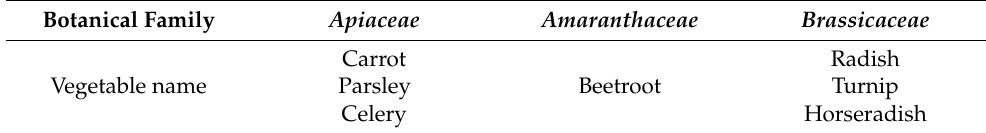
Table 2. Botanical families of root vegetables [21]. Botanical